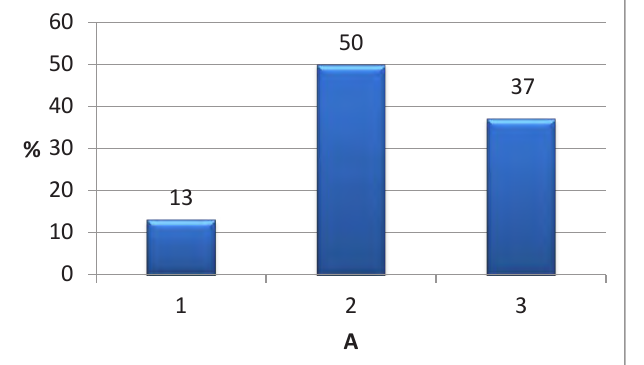
Fig. 3. Characteristic of traumas by heaviness of their impact on organism (%). A – Kinds of traumas: 1 – light traumas; 2 – moderate traumas; 3 – heavy